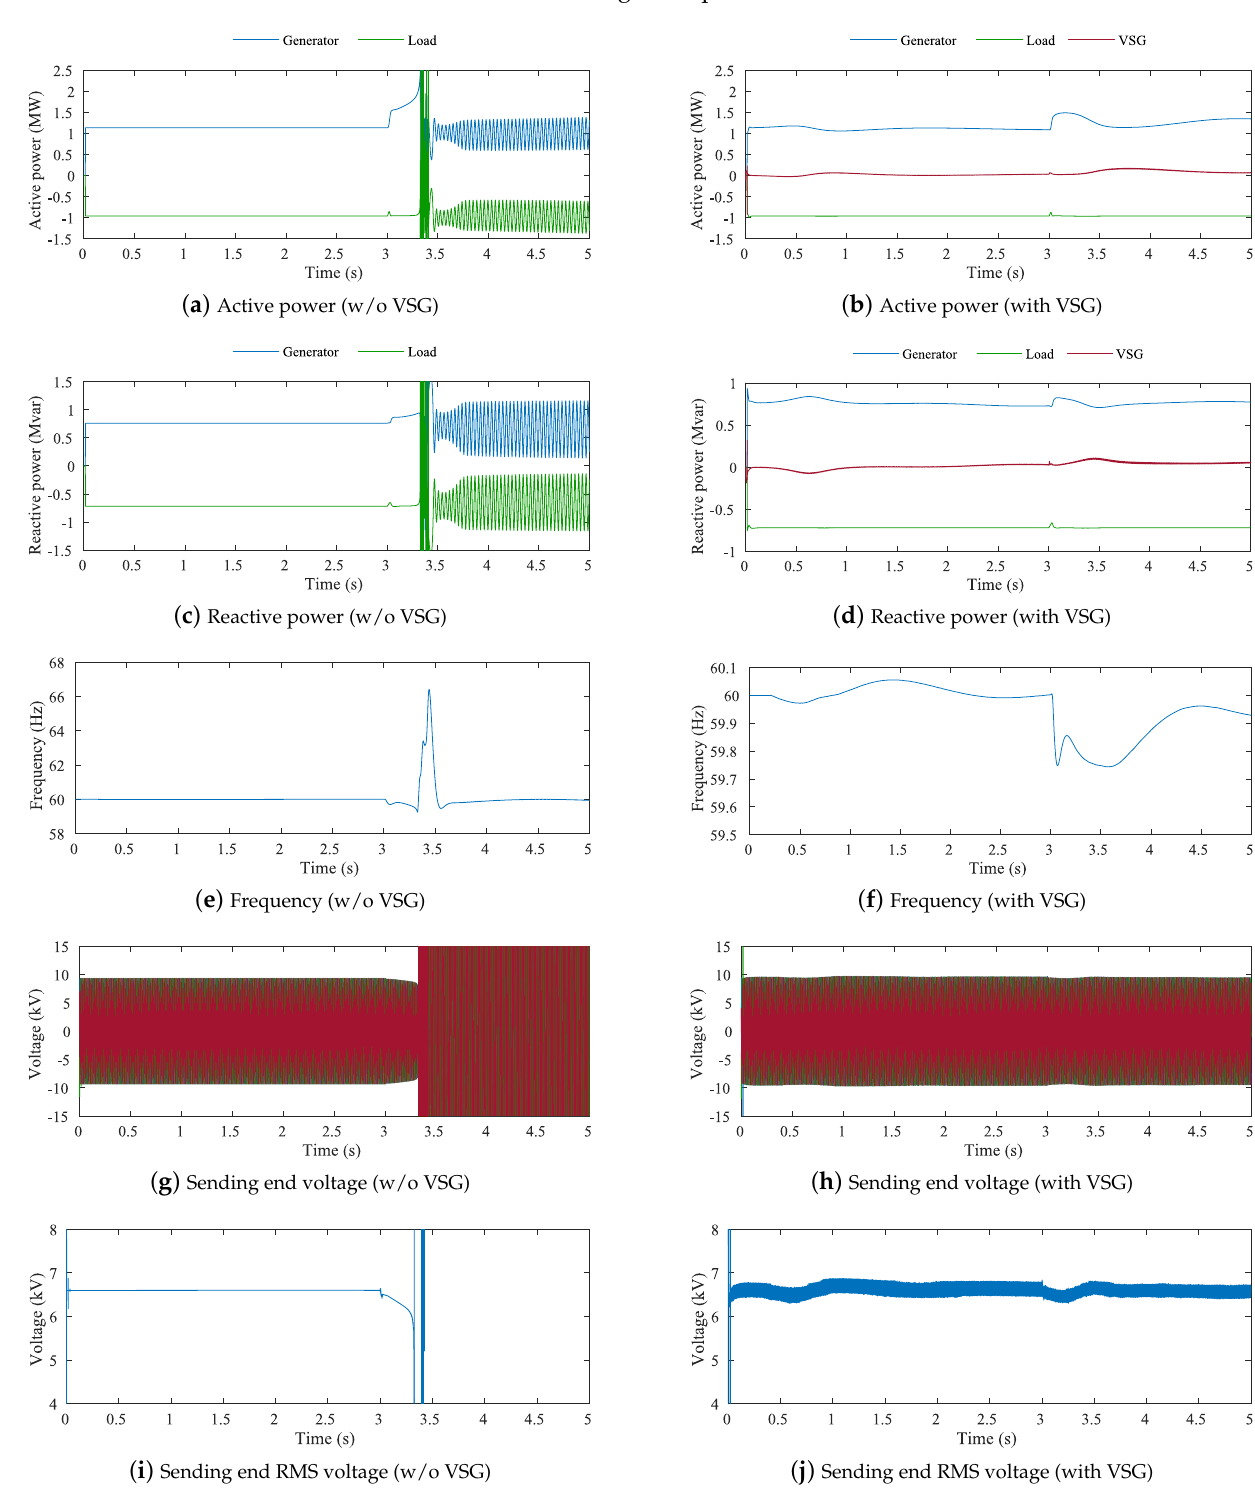
Figure 17. Simulation results of Case 2 with/without